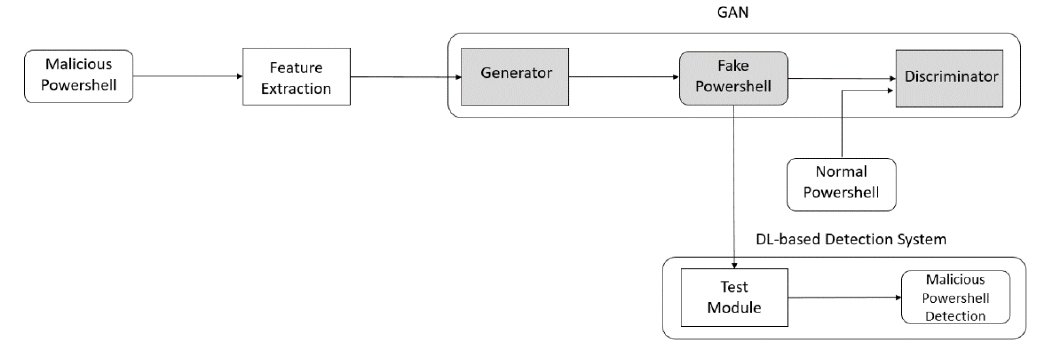
Figure 3. Adversarial Attack about Deep Learning-based PowerShell Detection.